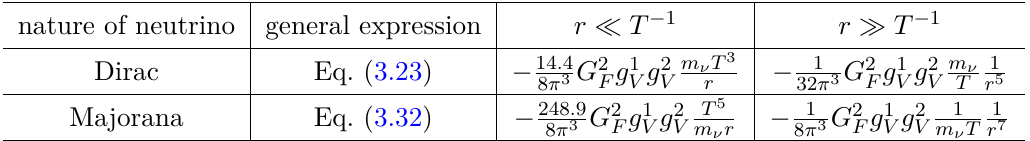
Table 3 . Comparison of the short- and long-range behavior of the background potential V bkg ( r ) in non-relativistic C ν B ( m ) with n taking the Fermi-Dirac distribution in eq. (3.4) for Dirac ν (cid:29) T ± and Majorana background